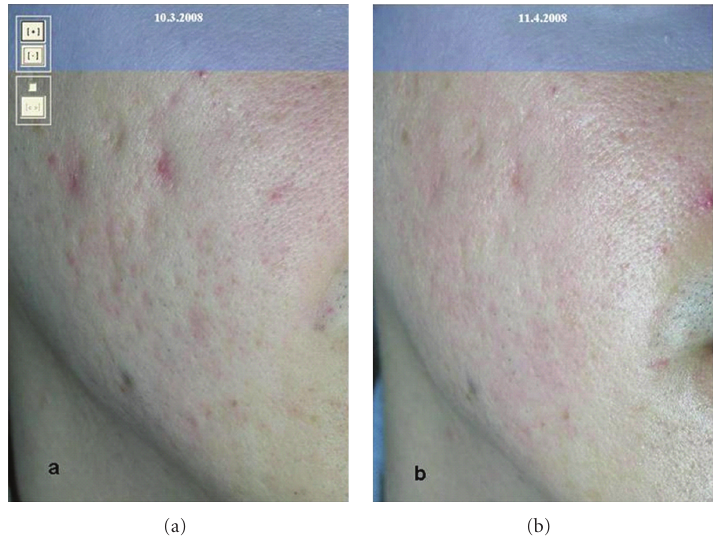
Figure 1: Acne scars at first (a) and after (b) only two treatments with fractional microablative CO 2 laser.